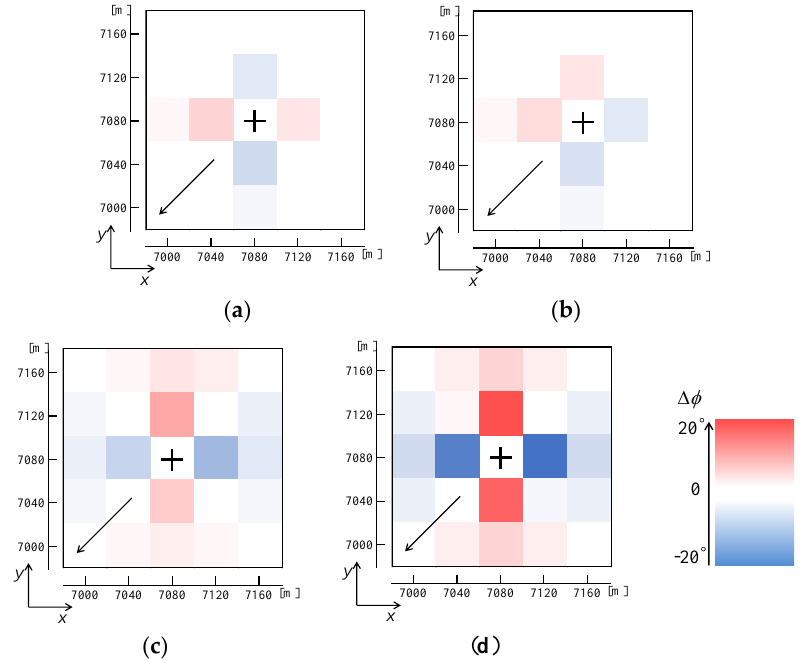
Figure 10. Color-coded azimuth error due to the presence of a nearby conducting structure having a height of 60 m and a square cross-section of 40 m × 40 m for true azimuth φ equal to 45 ˝ and different values of structure conductivity equall to ( a ) 0.1 mS/m; ( b ) 1 mS/m; ( c ) 10 mS/m; and ( d ) 1000 mS/m. Table 5. Azimuth errors estimated from Equation (2) for true azimuth φ equal to 45 ˝ and different values of structure conductivity equal to 0.1, 1, 10, 100, 1000